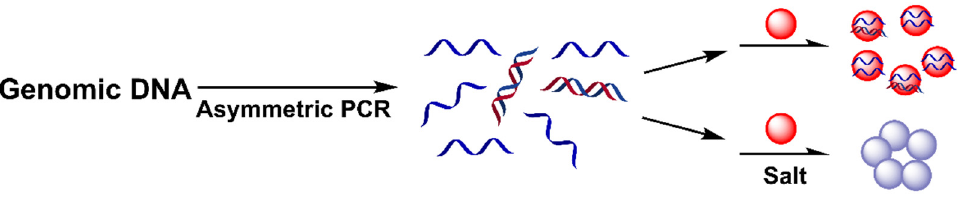
Figure 2. Schematic diagram of the colorimetric detection of the As-PCR DNA product with AuNP probe. Adapted with permission from ref [49]. Copyright 2012 Royal Society of Chemistry.